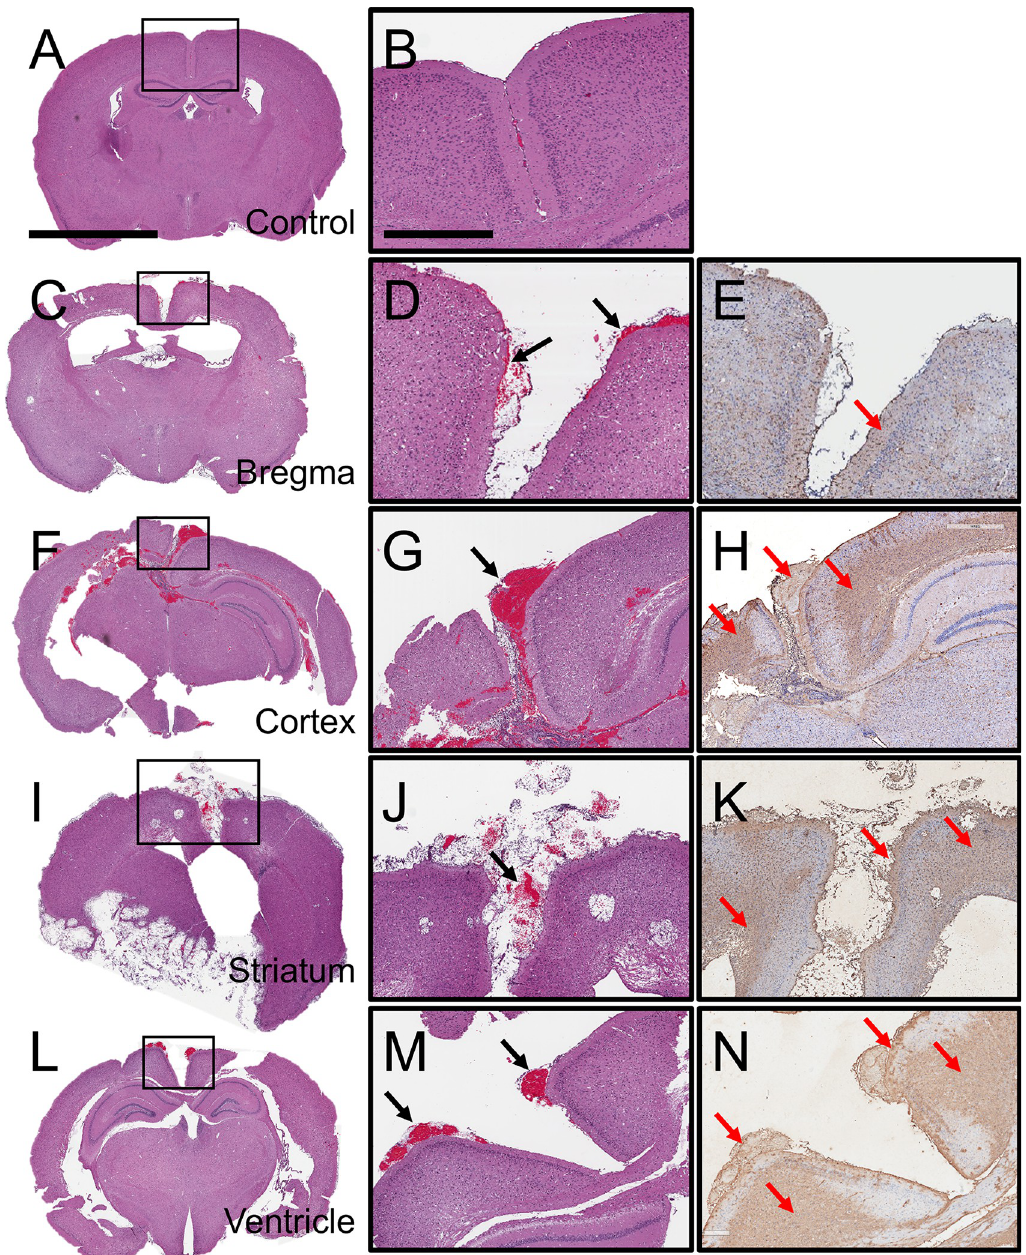
Fig 7. C . neoformans GXM localization is associated with subarachnoid space hemorrhage in i.c. infected mice. Representative coronal brain sections (scale bar: 2 mm) of (A-B) uninfected (control) and (C-E) bregma-, (F-H) cortex-, (I-K) striatum-, and (L-N) ventricle-infected mice with C . neoformans H99 strain. Each brain section was stained with H&E and GXM-binding mAb 18B7. Uninfected (control) and infected mice in bregma, cortex, and ventricle were euthanized 7-dpi. Striatum-infected rodents were sacrificed 20-dpi. Middle (H&E) and right (GXM-labeled; brown stain) panel images (scale bar: 200 μ m) are a magnification of the smaller box in the corresponding left H&E-stained section to better show the tissue morphology and GXM distribution. Black arrows indicate subarachnoid space hemorrhage. Red arrows demonstrate GXM accumulation in the subarachnoid space. Five mice per infection route were evaluated to confirm all the histopathological observations reported in these